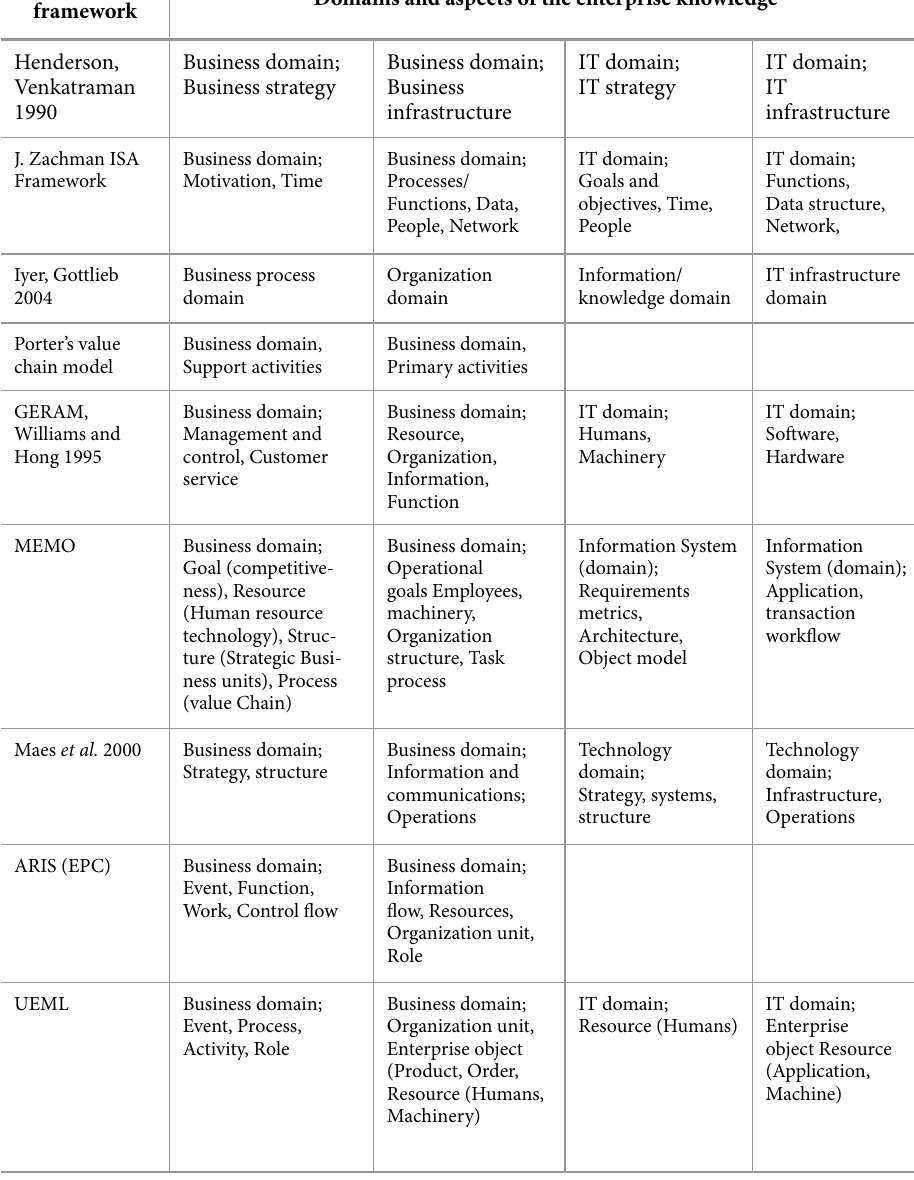
Table 1. Domains and aspects of the enterprise knowledge Modelling